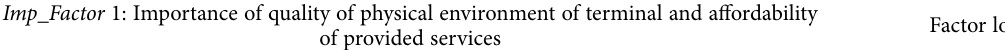
Table 11. Importance Factor 1 factor loadings